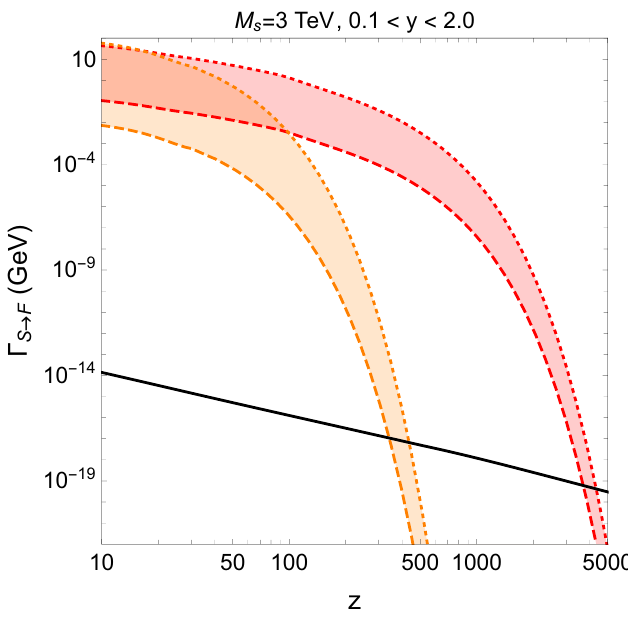
Figure 5 . The sum of the 2 ! 1 and 2 ! 2 rates compared with the Hubble rate for M S = 3 TeV, (cid:1) M=M S = 0 : 1 (orange) and (cid:1) M=M S = 0 : 01 (red), and for 0 : 1 (cid:20) y (cid:20) 2 : 0. On the x -axis z = M S =T is the time variable of the Boltzmann